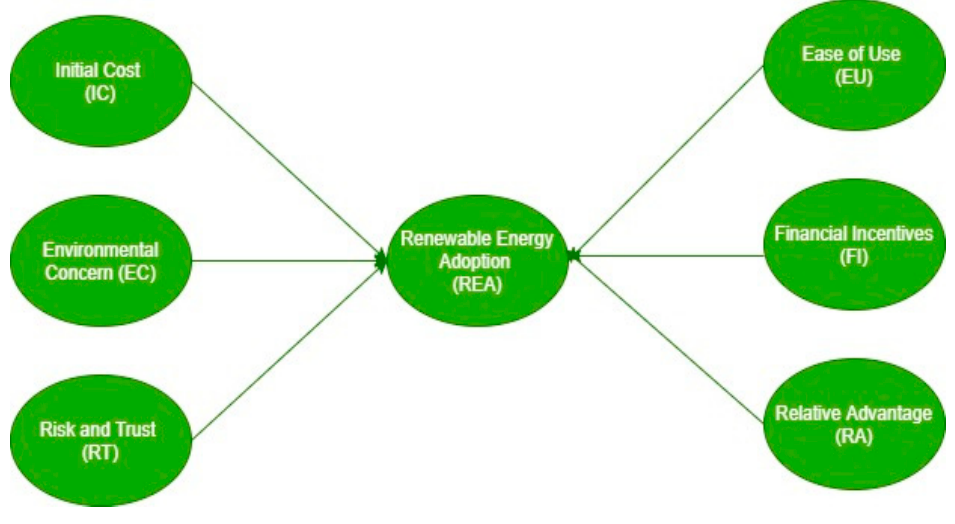
Figure 1. Research